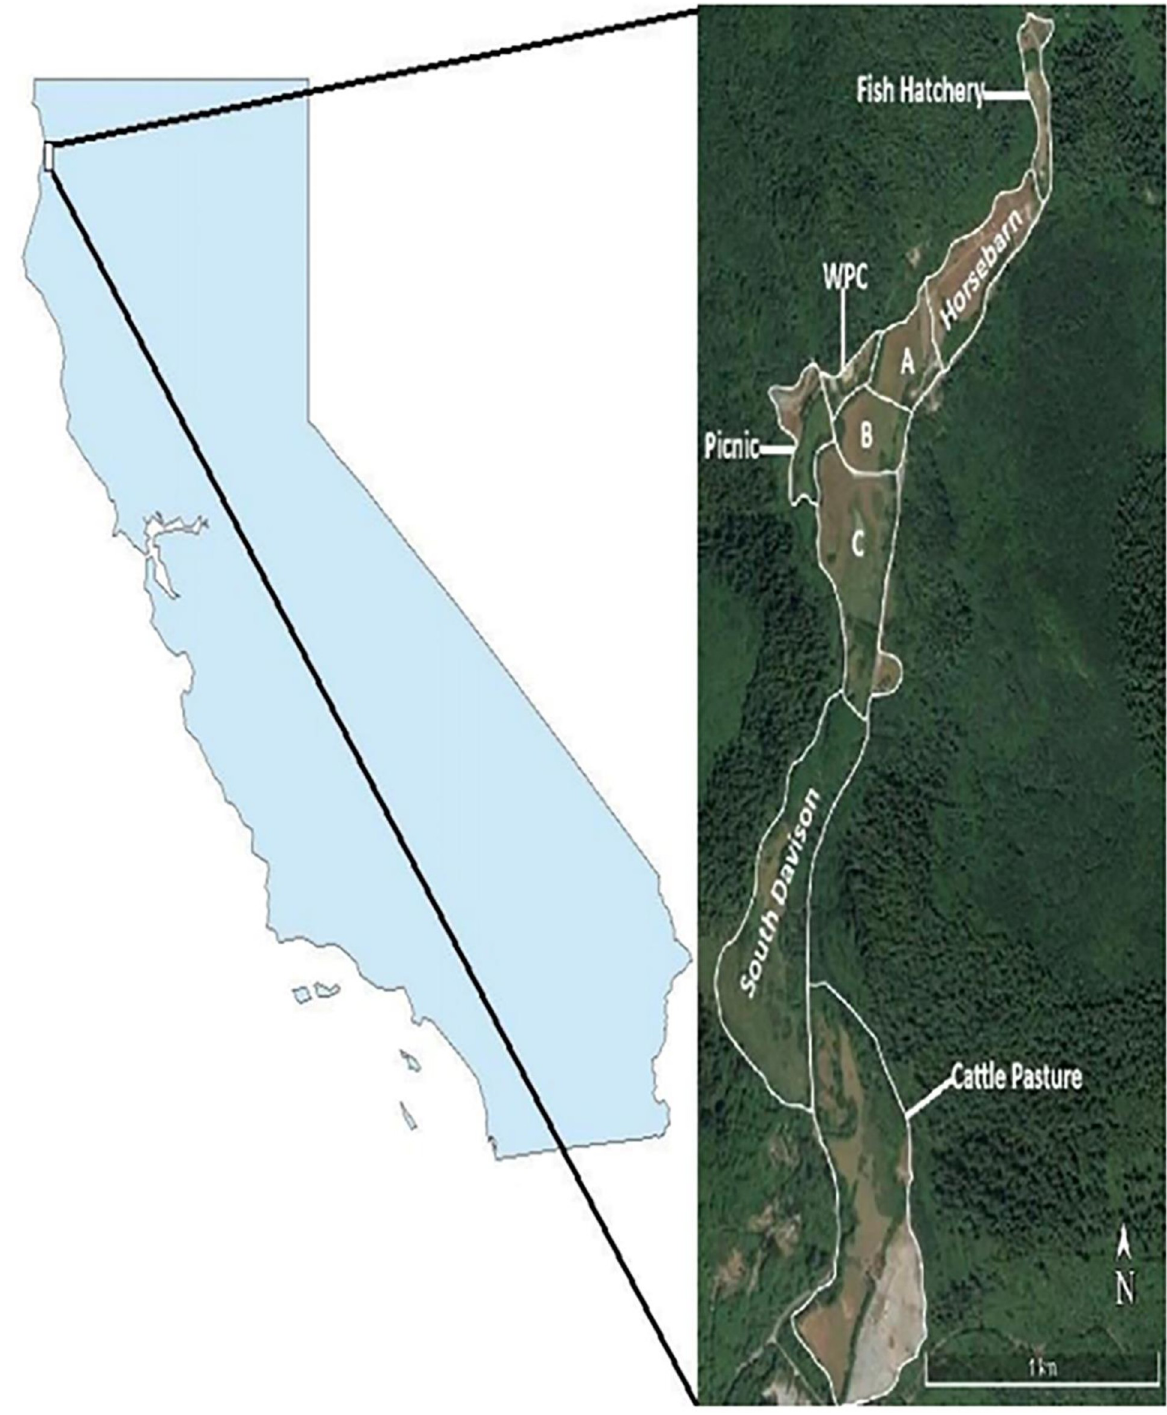
Fig 1. Map of the Davison meadow complex in Redwood National and State Parks and location of the parks in California. Within the meadow complex the sectors are delineated and named. The areal image was obtained from the National Agriculture Imagery Program (NAIP) from the USDA Farm Services Agency, is in the public domain, and has not been copyrighted to our knowledge.